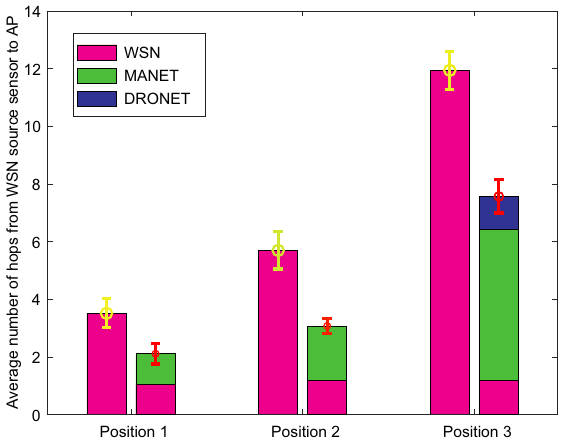
Figure 23. The average number of hops from source WSN sensor to AP.